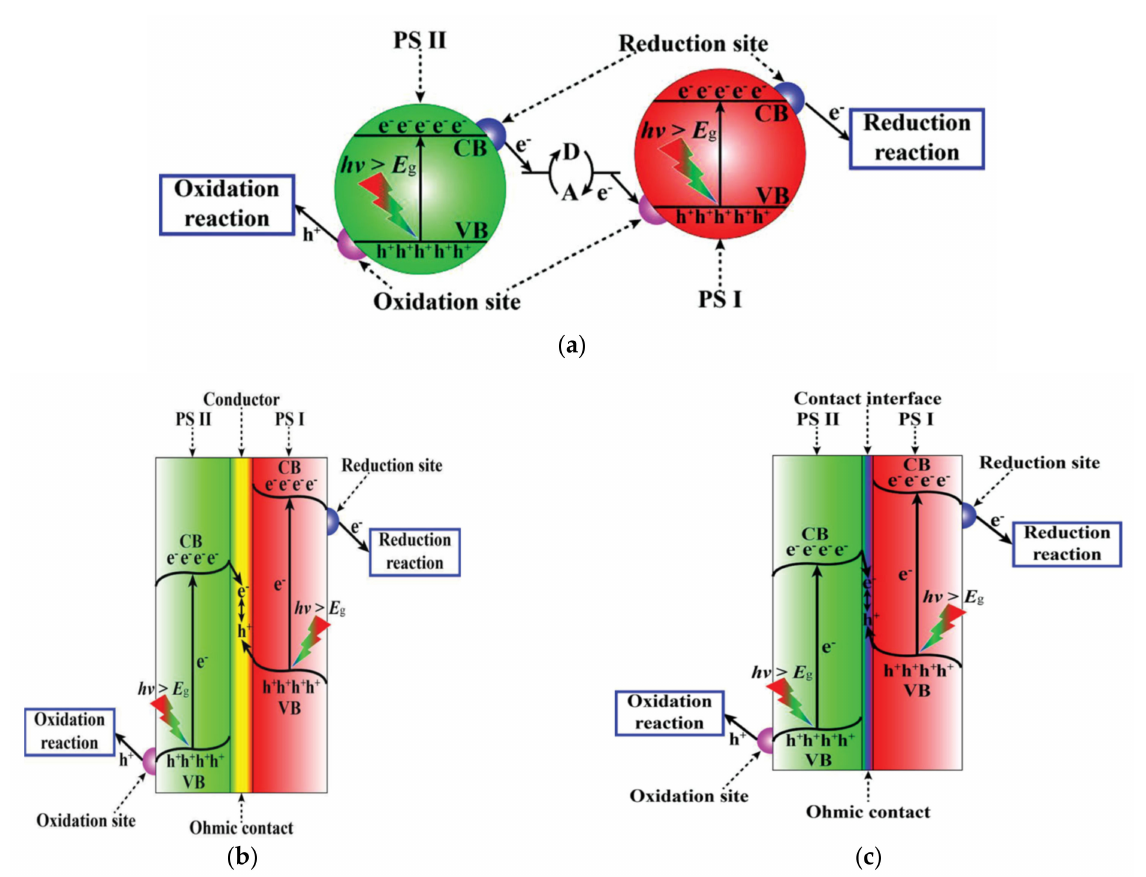
Figure 10. Schematic diagram of Z-scheme electron transfer in ( a ) PS-A/D-PS, ( b ) PS-C-PS, and ( c ) PS-PS system. Repro- duced with permission from Zhou P et al, Advanced Materials; published by John Wiley and Sons,